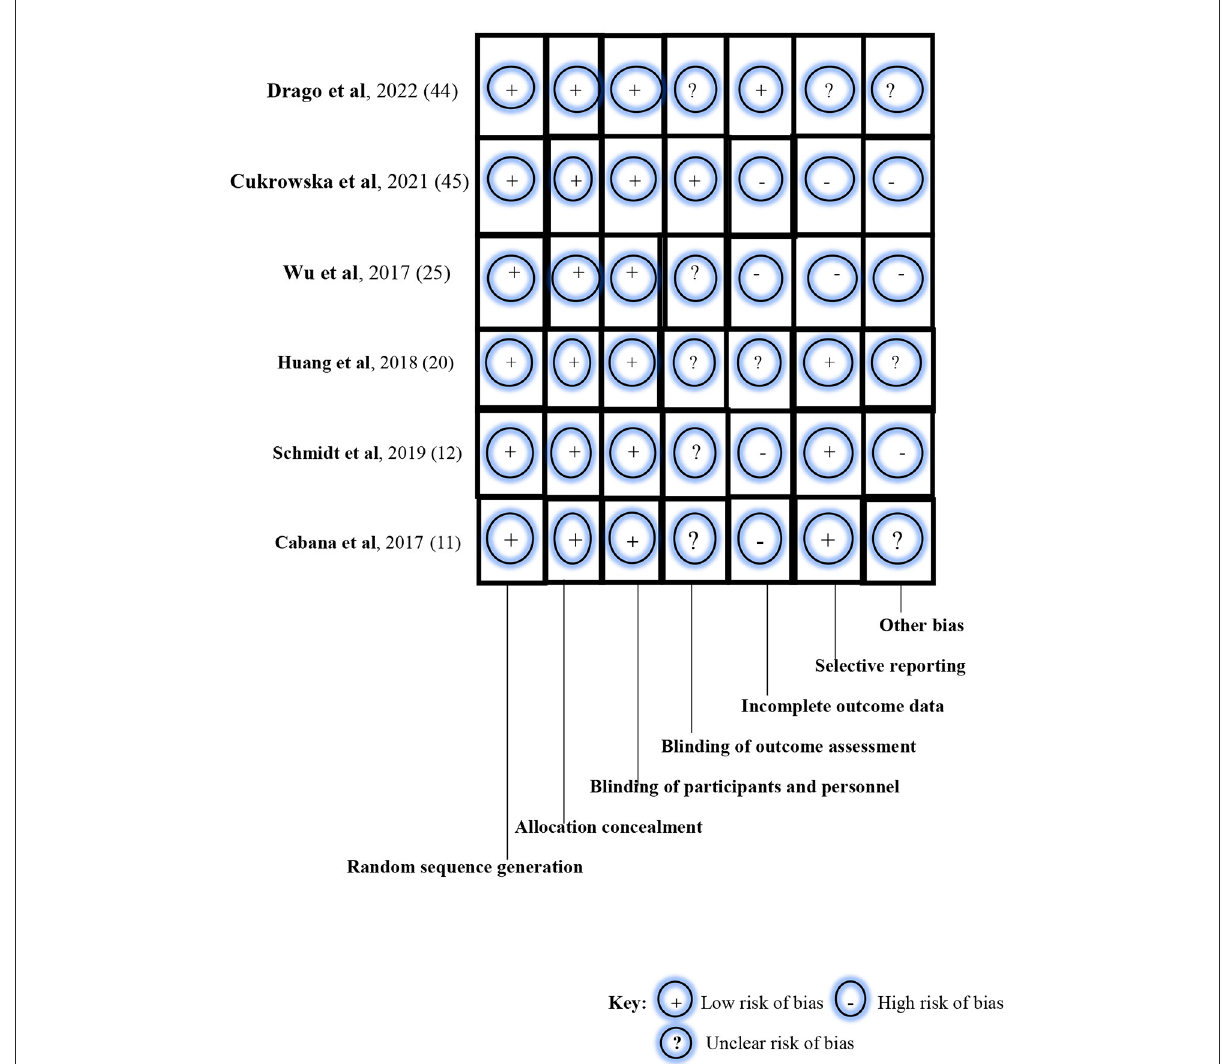
FIGURE2 Risk-of-bias assessment of the randomized controlled trials using the Cochrane Collaboration’s